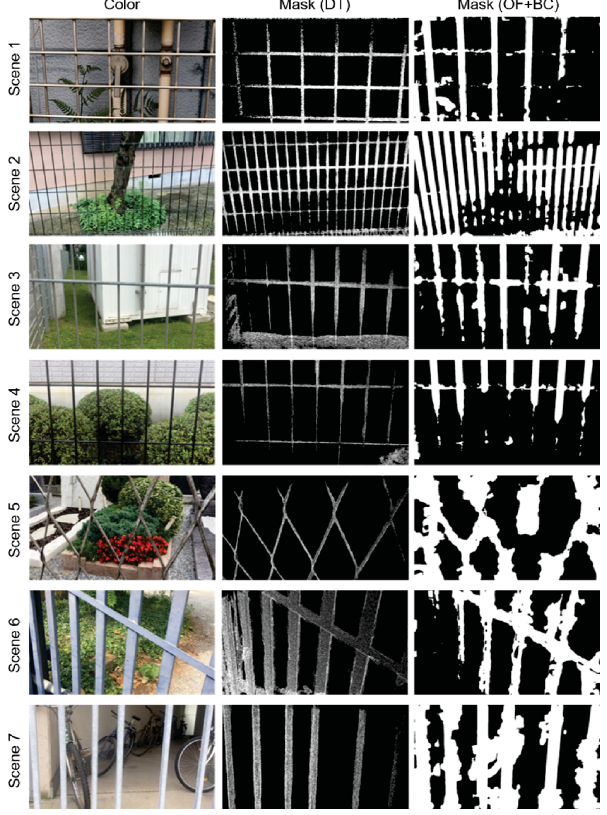
Fig. 7 Fence detection in experimental